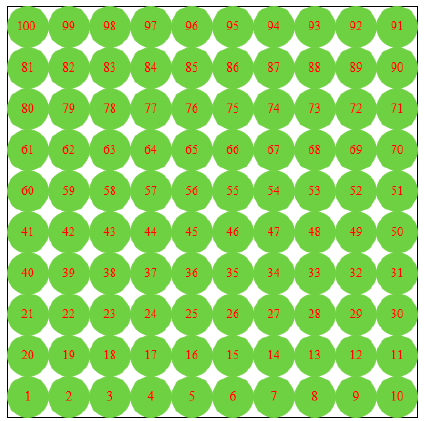
Figure 21. Schematic diagram of sample measurement circle layout in the direct shear